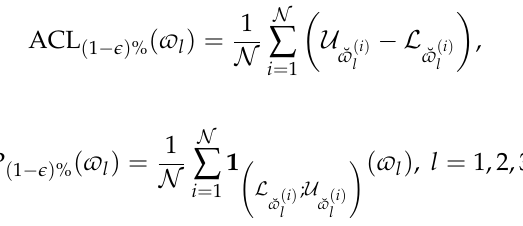
respectively, where 1 ( · ) is the indicator function, and L ( · ) is the lower bound and U ( · ) is the upper bound of asymptotic (or credible) interval